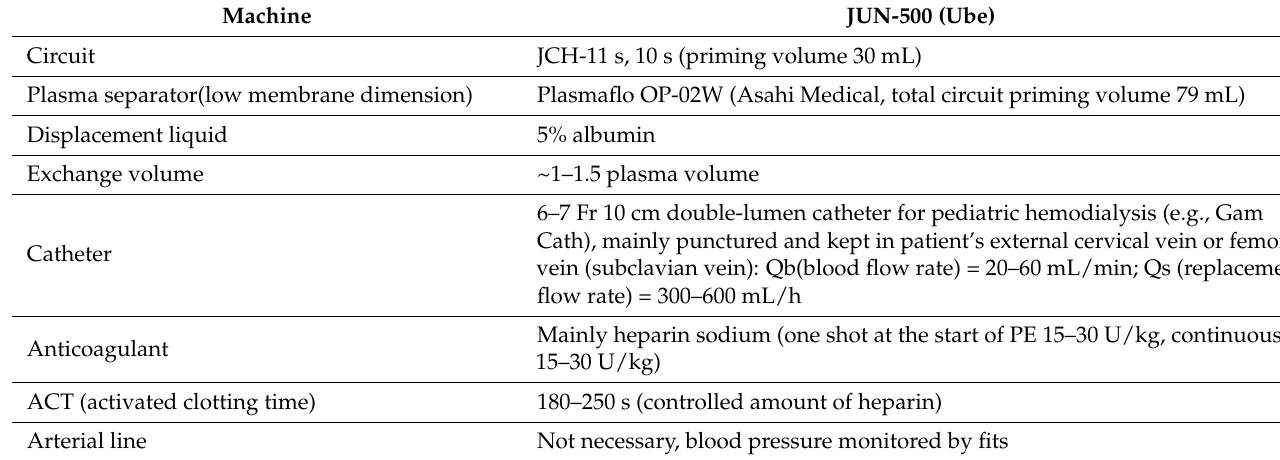
Table 3. Method and procedure of plasma exchange (PE)